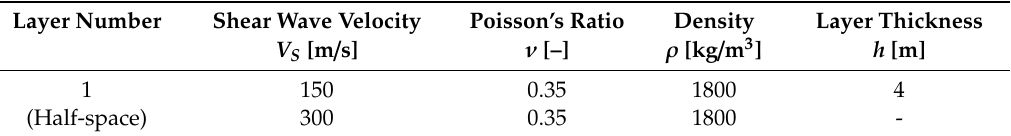
Table 1. Model A, two-layer model characterized by an increase in shear wave velocity with depth.